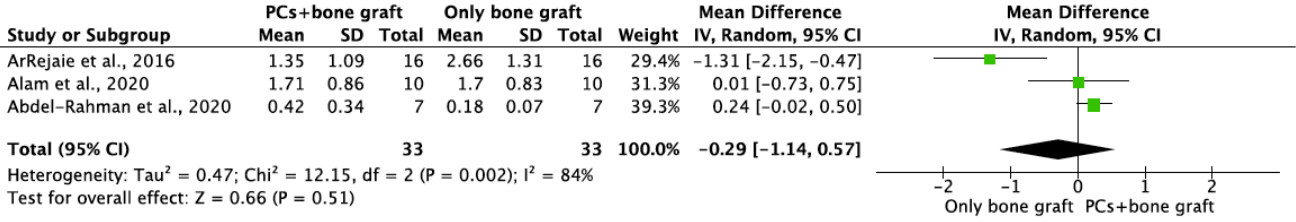
Figure 4. Random-effect meta-analysis evaluating MBL in both aspects at 6 months in immediate implants procedures with PCs + bone graft vs. only bone graft.